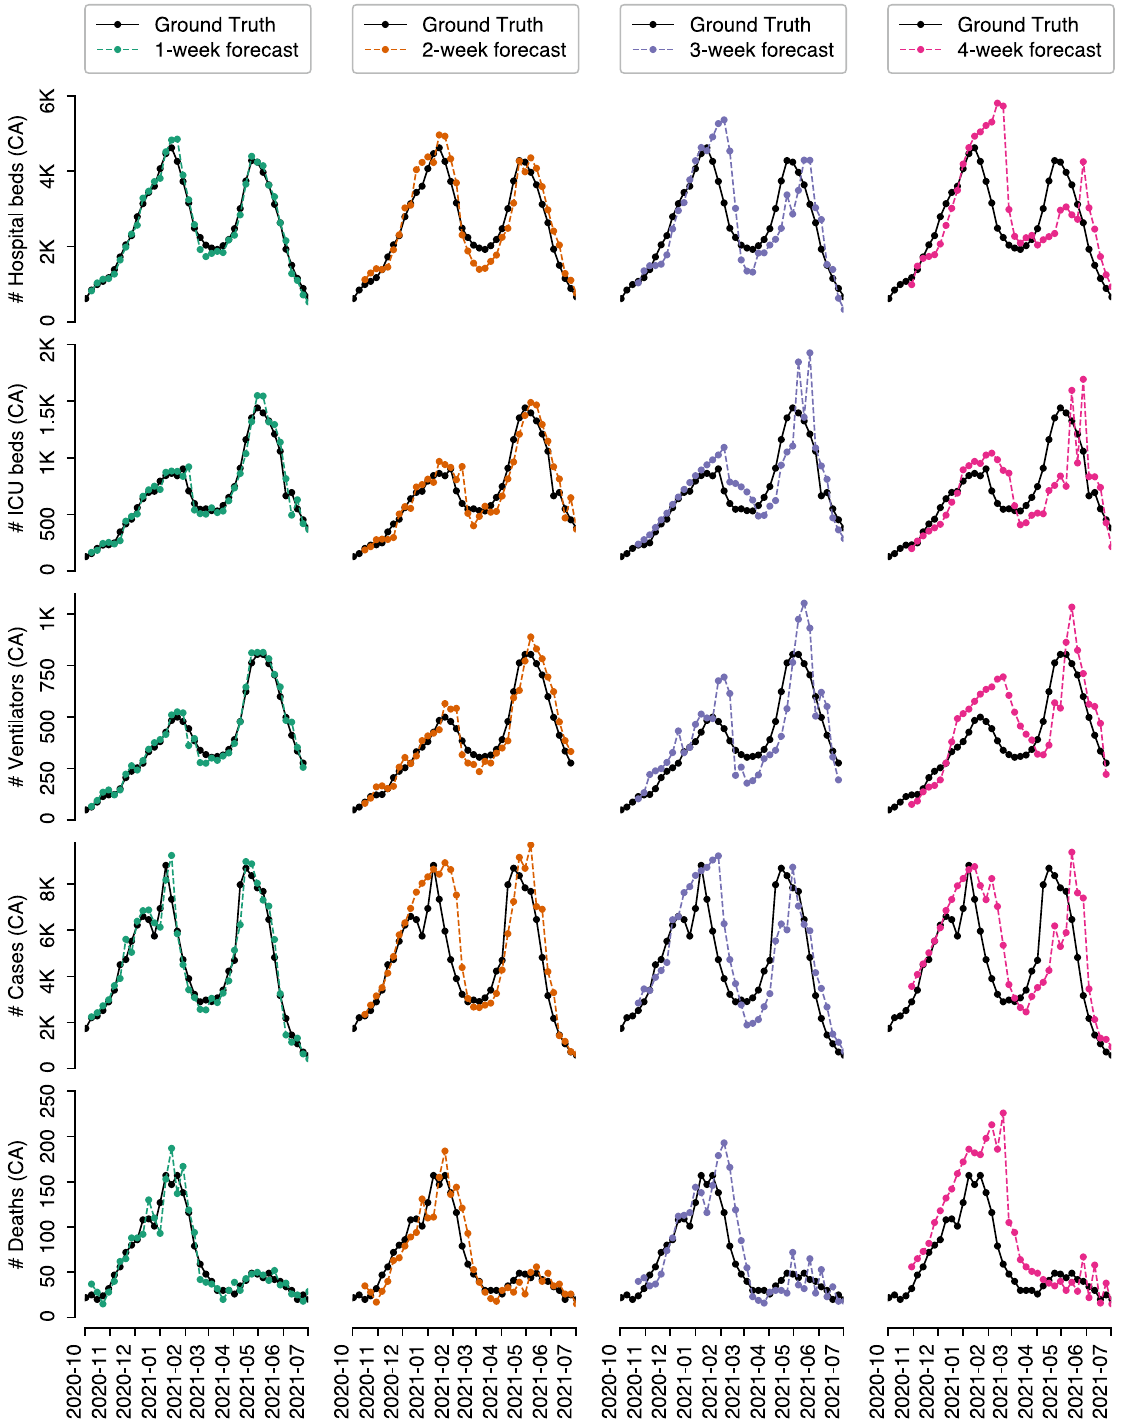
Figure 3. TCN’s 1-,2-,3-,4-week forecasts of the weekly average number of hospital beds, ICU beds, ventilators, cases, and deaths in Canada between 2 Oct 2020 and 2 July